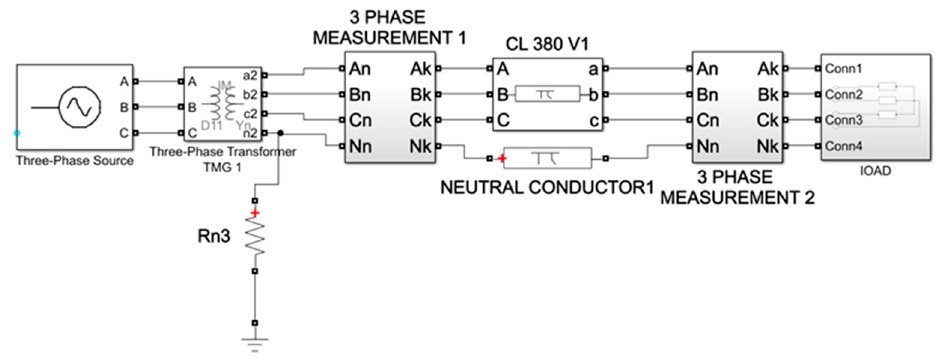
Figure 5. Model of a section of the urban electricity distribution network with 148 consumers connected. The model parameters are shown in Table